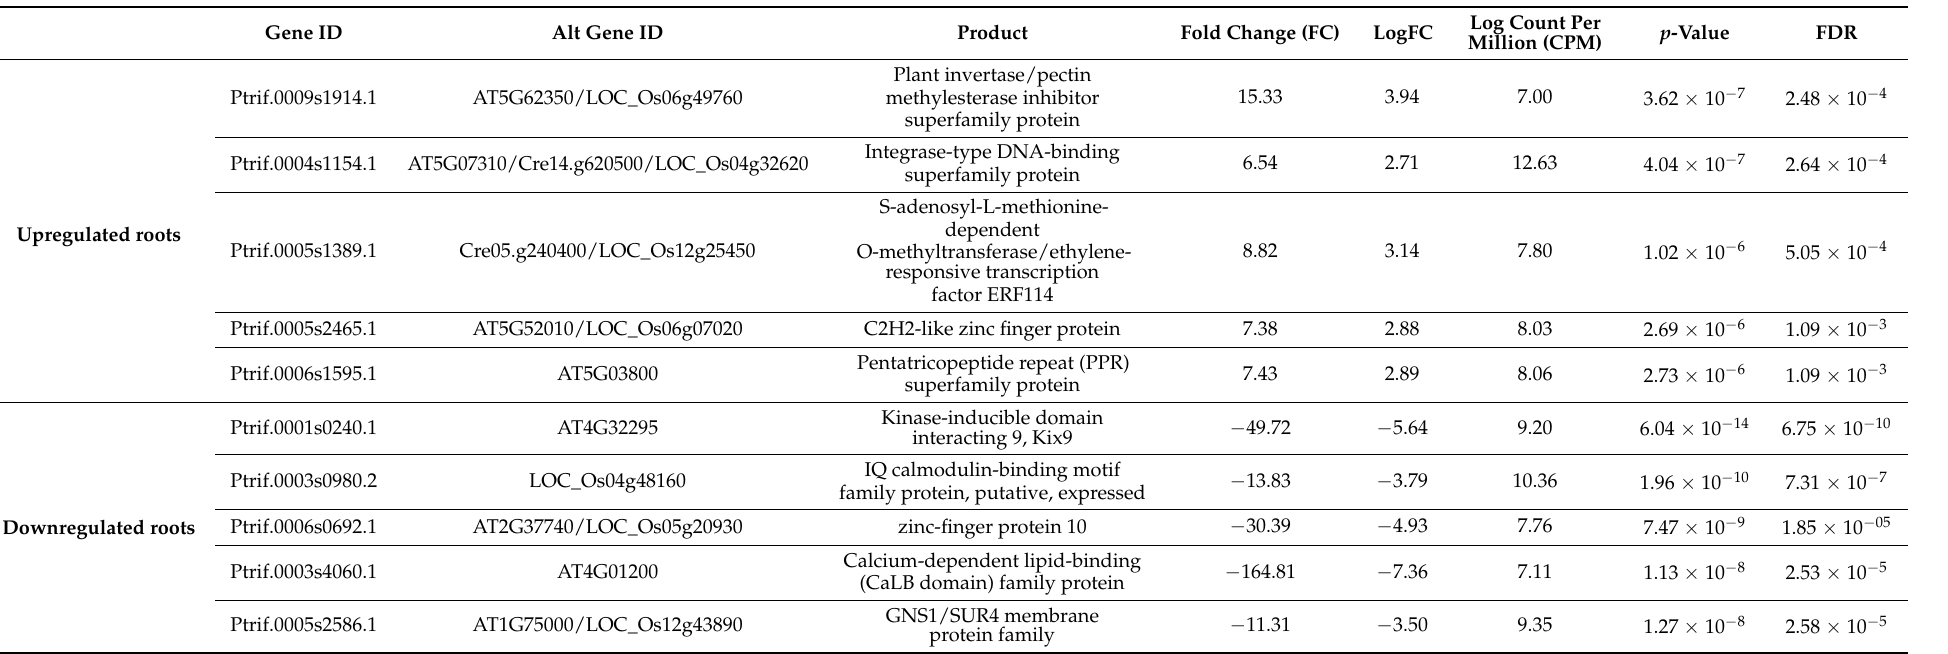
Table 4. List of top 5 up and downregulated differentially expressed genes (DEGs) in non-infected vs. citrus dwarfing viroid (CDVd)-infected for roots tissues based on the